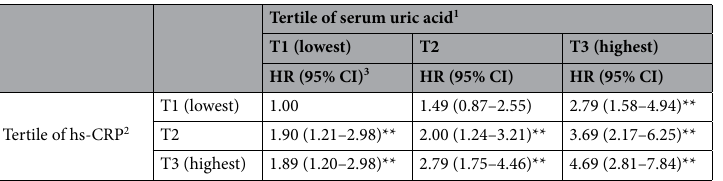
Table 4. Association of type 2 diabetes by serum uric acid and high-sensitivity C-reactive protein level strata in Korean adults aged 45–76 years. T tertile; hs-CRP high-sensitivity C-reactive protein; HR hazard ratio; CI confidence interval. 1 Cut-offs for tertiles 1–3 of serum uric acid levels are as follows: < 5.2, 5.2–6.1, and > 6.1 mg/dL in men and < 3.8, 3.8–4.4, and > 4.4 mg/dL in women, respectively. 2 Cut-offs for tertiles 1–3 of hs-CRP levels are as follows: < 0.45, 0.45–1.04, and > 1.04 mg/L in men and < 0.38, 0.38–0.89, and > 0.89 mg/L in women, respectively. 3 Individuals in the lowest tertile of serum uric acid and hs-CRP levels are used as the reference group. The model is adjusted for sex (men or women), age (years), area of residence (Ansan or Ansung), education level (≤ elementary school, middle/high school, or ≥ college), smoking status (never, past, or current), alcohol consumption (g/d), regular physical activity (yes or no), body mass index (kg/m 2 ), waist circumference (cm), systolic and diastolic blood pressure (mmHg), triglyceride (mg/dL), total cholesterol (mg/ dL), high-density lipoprotein cholesterol (mg/dL) and fasting blood glucose level (mg/dL), and family history of diabetes (yes or no). ** P < 0.001.